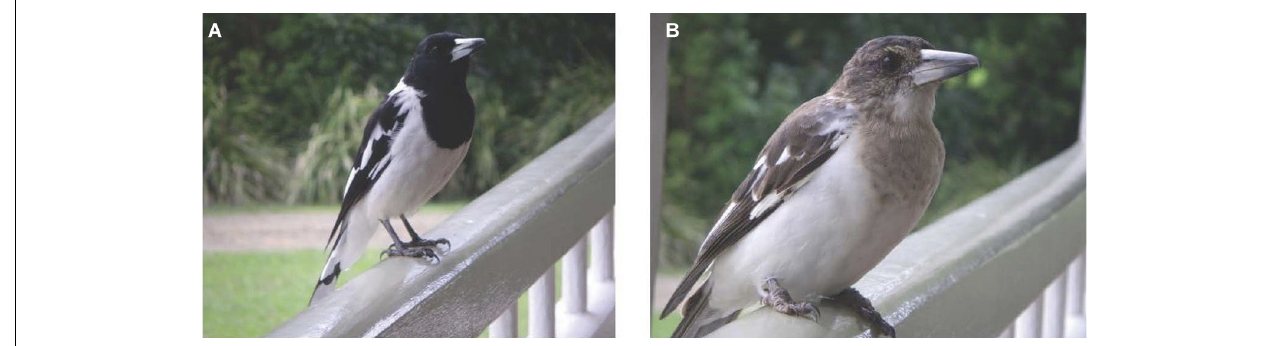
FIGURE 2 | (A,B) An adult (l.) and an immature (r.) pied butcherbird perch on the deck rails, waiting for (and apparently singing for) a feeding at the Maleny property.